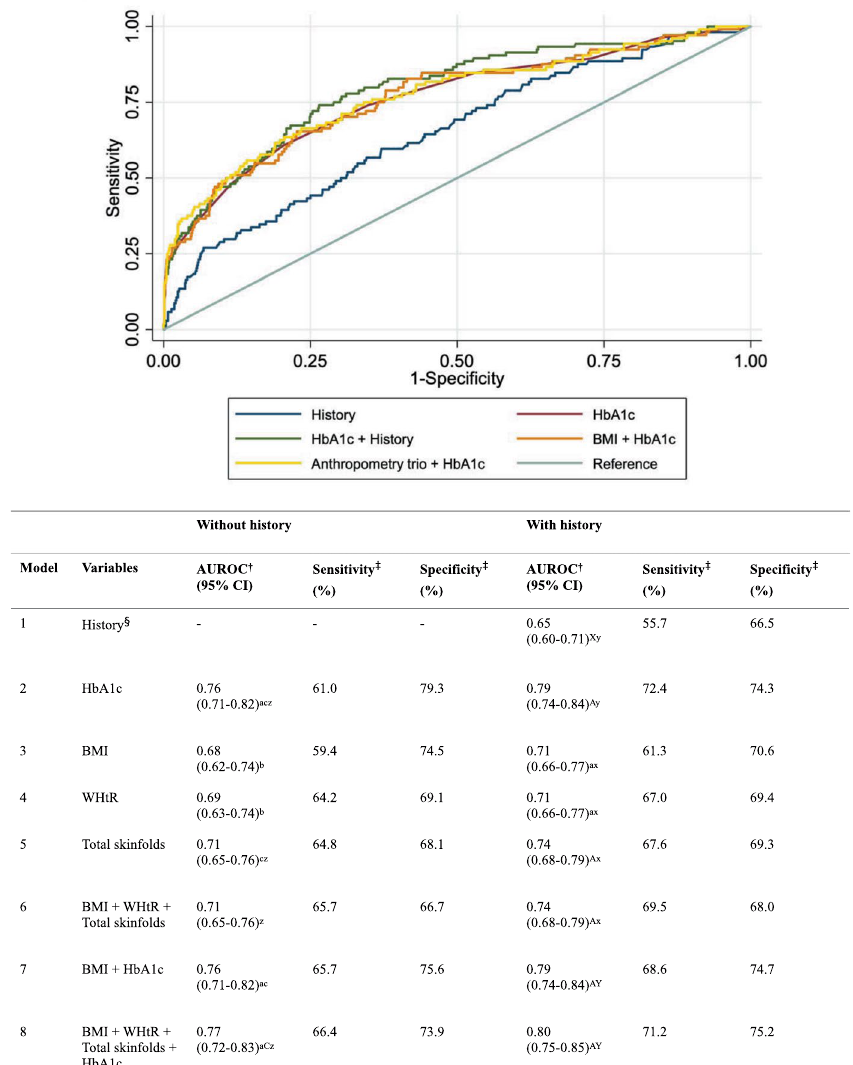
Figure 1. Continuous measures of anthropometry and HbA1c – The AUROC, sensitivity and specificity in detecting dysglycemia without and with adjustment for